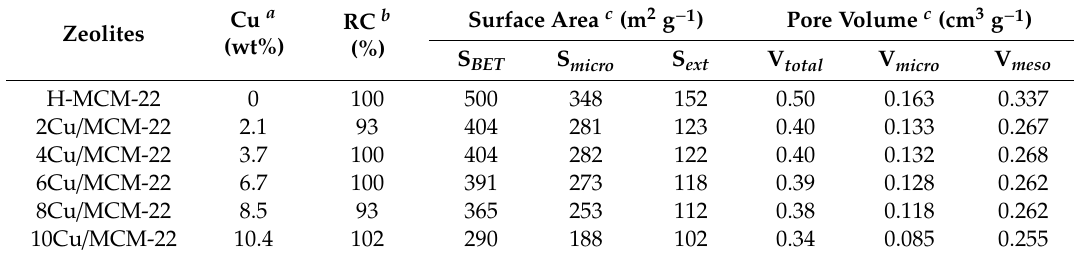
Figure 2. XRD patterns of H-MCM-22 and x Cu/MCM-22 zeolites. Table 1. Physicochemical properties of x Cu / MCM-22 zeolites with di ff erent copper